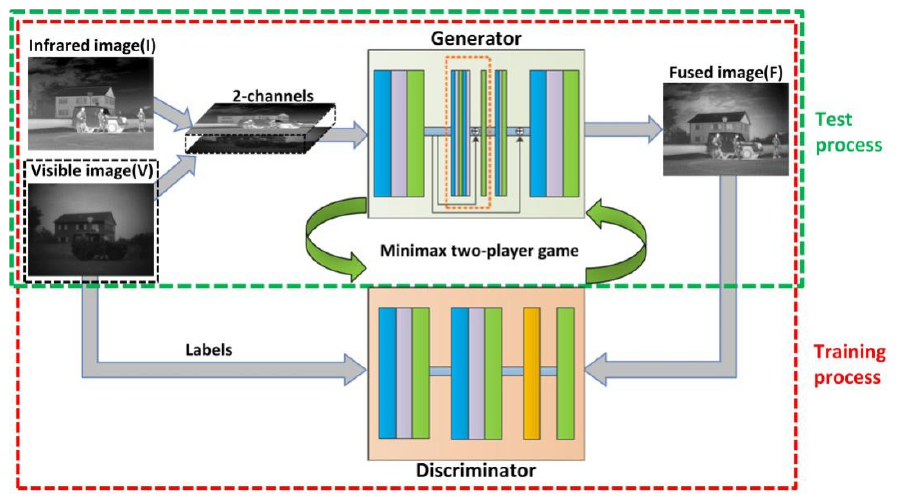
Figure 3. The framework of infrared and visible image fusion.